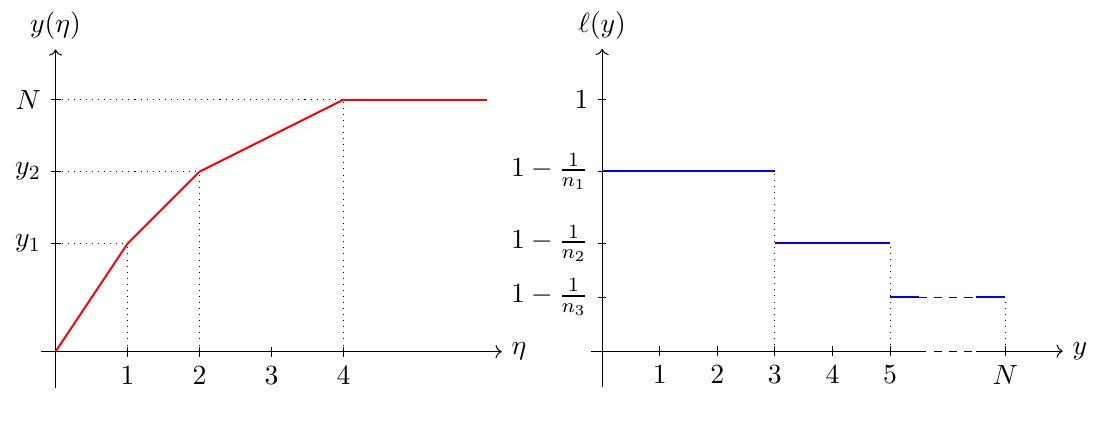
Figure 3 . piecewise linear function y ( (cid:17) ) and the accompanying step function ‘ ( y ) .